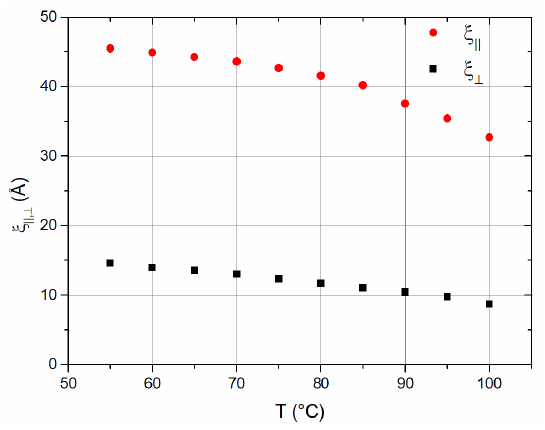
Figure 11. Longitudinal ( ξ (cid:107) , red circles) and transverse ( ξ ⊥ , black squares) positional correlation lengths as a function of the temperature T . Data obtained from the analysis of the SA diffraction patterns as described in the text.